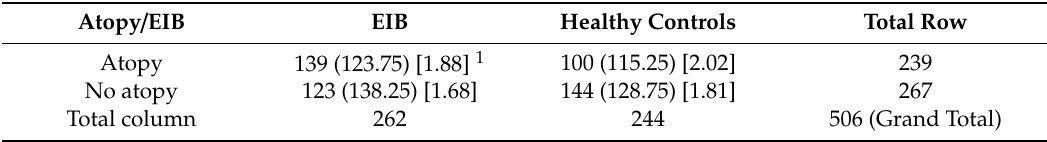
Table 5. Atopic status in athletes with and without EIB.